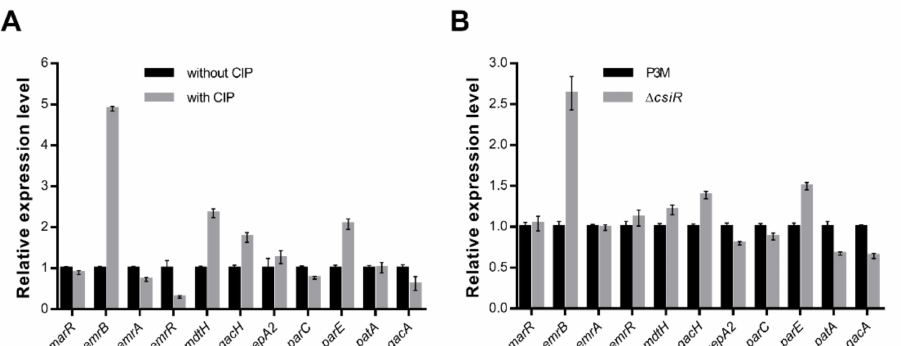
Figure 3. Relative mRNA expression levels of selected quinolone resistance genes with and without ciprofloxacin treatment ( A ), in wild-type and mutant backgrounds ( B ). Data were obtained from three independent repeated tests. Expression data were obtained from three independent repeated tests ( n = 3).